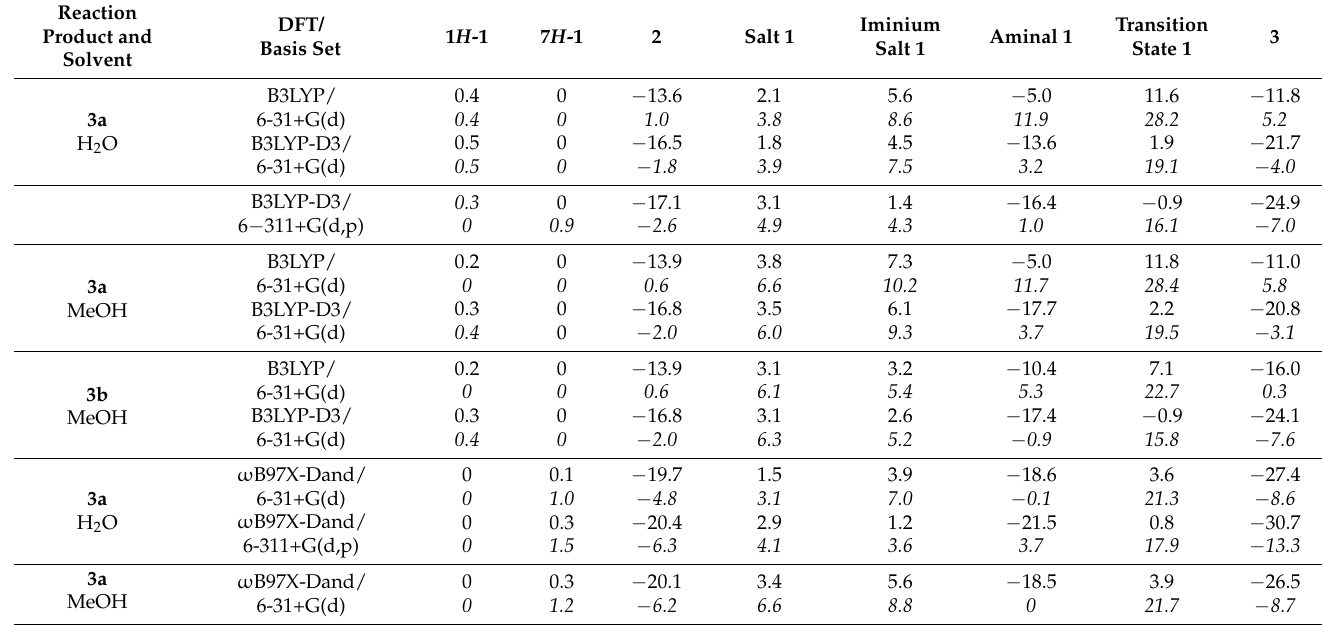
Table 1. The relative electronic (plain text) and Gibbs free (italics) energies (kcal/mol) of subsequent stages of the tandem Mannich—electrophilic amination reactions calculated by DFT/PCM methods. Reaction Product and